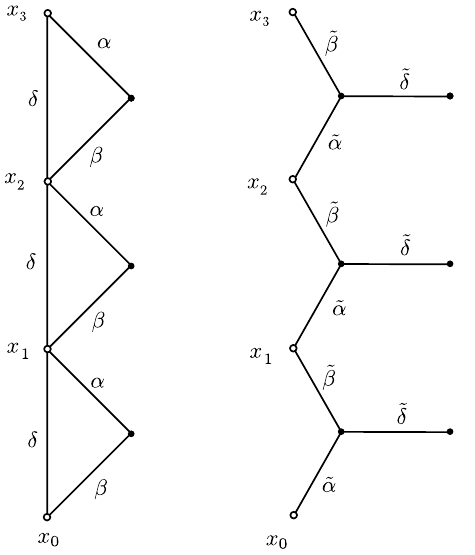
Figure 10 . Transfer-matrix operator Q 3 ( u ) as an integral operator with the kernel represented in Feynman diagram notation. The two equivalent forms are related by star-triangle